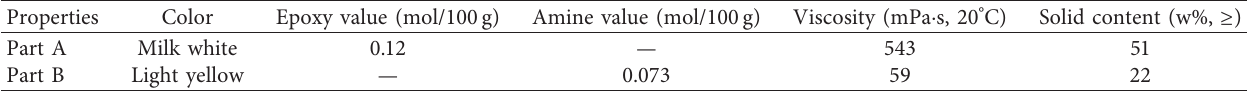
Table 2: Properties of waterborne epoxy resin.